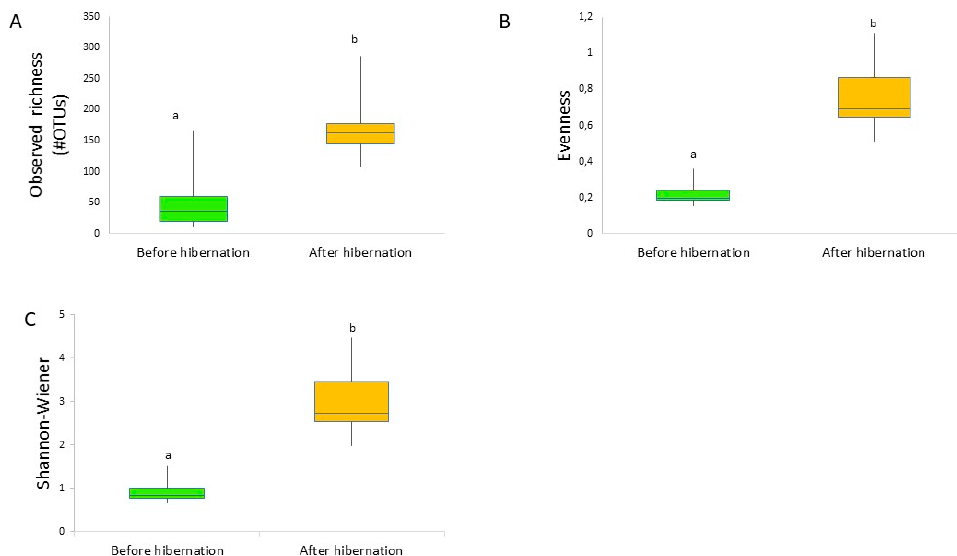
Figure 1. Observed richness ( A ), evenness ( B ), and Shannon–Wiener diversity ( C ) boxplots of the gut bacteria occurring in the midgut and/or ileum in indoor-reared bumblebee queens ( Bombus terrestris ) before ( n = 15) and after hibernation ( n = 15). The boxplots show the upper and lower quartiles; the whiskers indicate variability outside the upper and lower quartiles. Further, the median is plotted. Diversity indices were significantly different ( p < 0.05) between treatments (Shannon–Wiener values were first exponentially transformed before performing the statistical analysis).